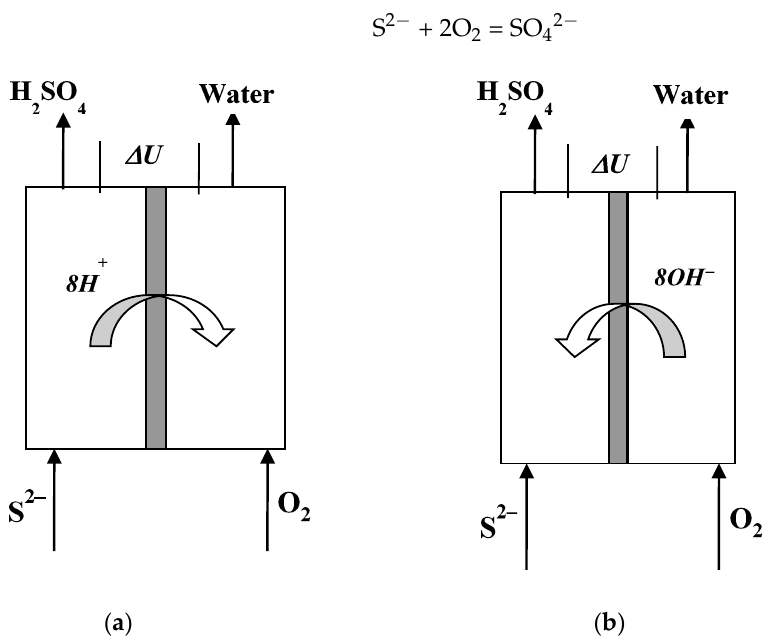
Figure 1. Principal sketch of sulfide driven fuel cell. ( a ) by proton transfer through the membrane; ( b ) by hydroxylic anion transfer through the membrane. The enthalpy of the latter reaction (4) is − 774 kJ mole − 1 . For a reference, the enthalpy of methane combustion is − 890.8 kJ mole − 1 and for hydrogen combustion − 568.8 kJ mole − 1 . The theoretical electromotive force of such a fuel cell element is 1.08 V. The final product is sulfate ions in moderate concentration being compatible with the natural sea